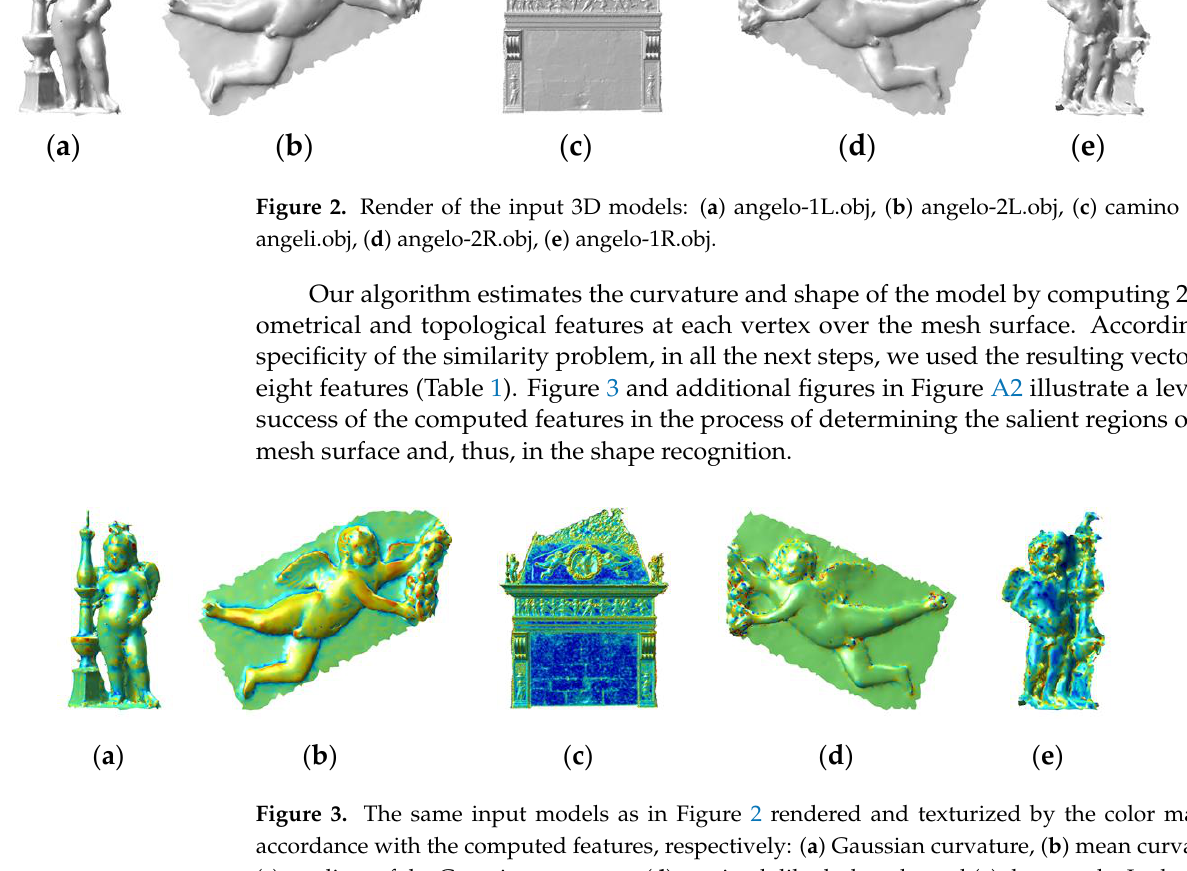
Figure 3. The same input models as in Figure 2 rendered and texturized by the color map in accordance with the computed features, respectively: ( a ) Gaussian curvature, ( b ) mean curvature, ( c ) gradient of the Gaussian curvature, ( d ) maximal dihedral angle, and ( e ) theta angle. In the used color map, blue corresponds to low values and red to high values of the computed feature.